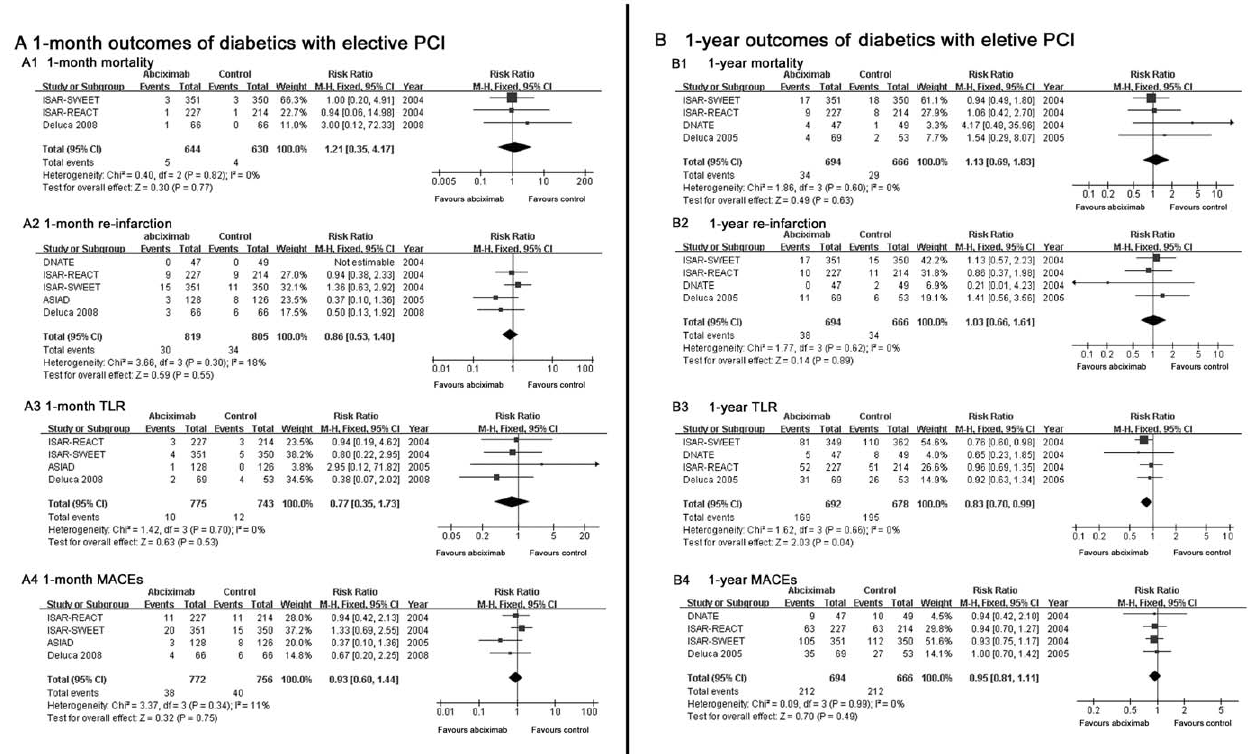
Figure 2. Comparison of 1-month and 1-year outcomes between abciximab and control group in patients with elective PCI. Efficacy of abciximab compared with control for (A1): 1-month mortality and (B1): 1-year mortality; (A2): 1-month reinfarction and (B2): 1-year reinfarction; (A3): 1-month TLR and (B3): 1-year TLR; (A4): 1-month MACEs and (B4): 1-year MACEs in diabetic patients with elective PCI.